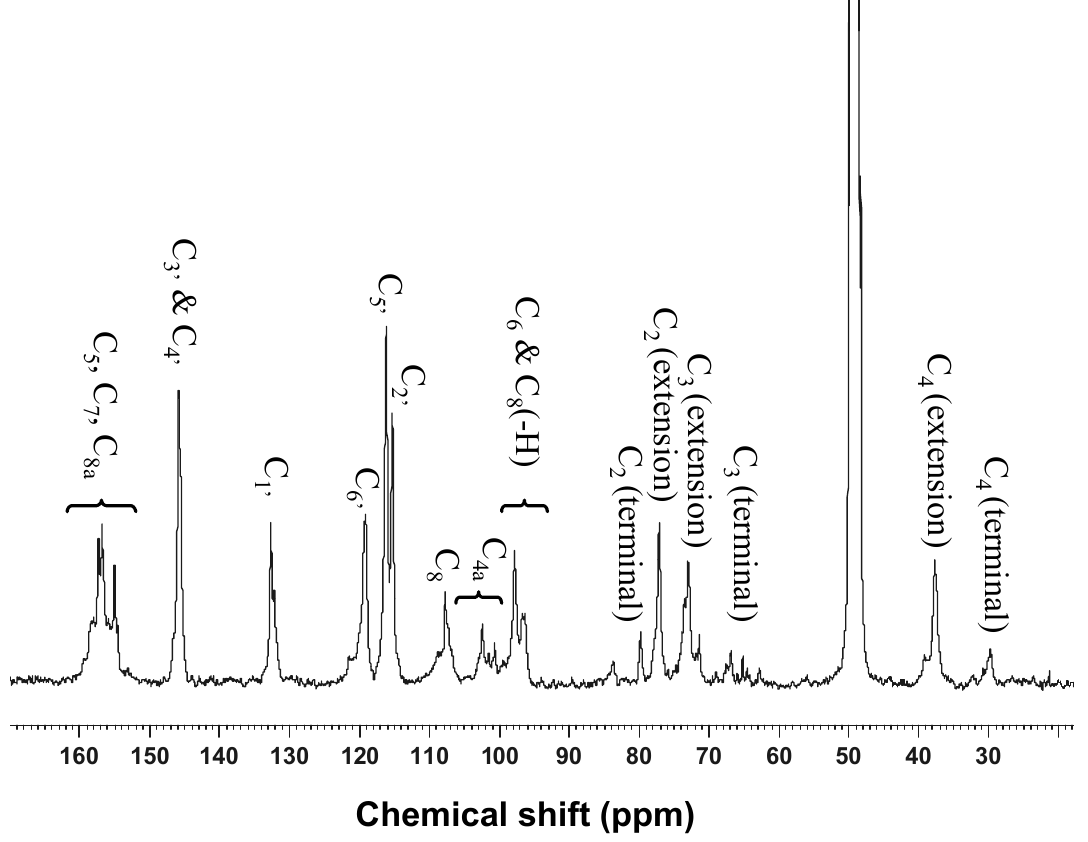
Figure 3. 13 C{ 1 H}-NMR spectrum of proanthocyanidins from durian seed. Sample was dissolved in deuterate methanol and the data were collected at room temperature with operating frequency of 75